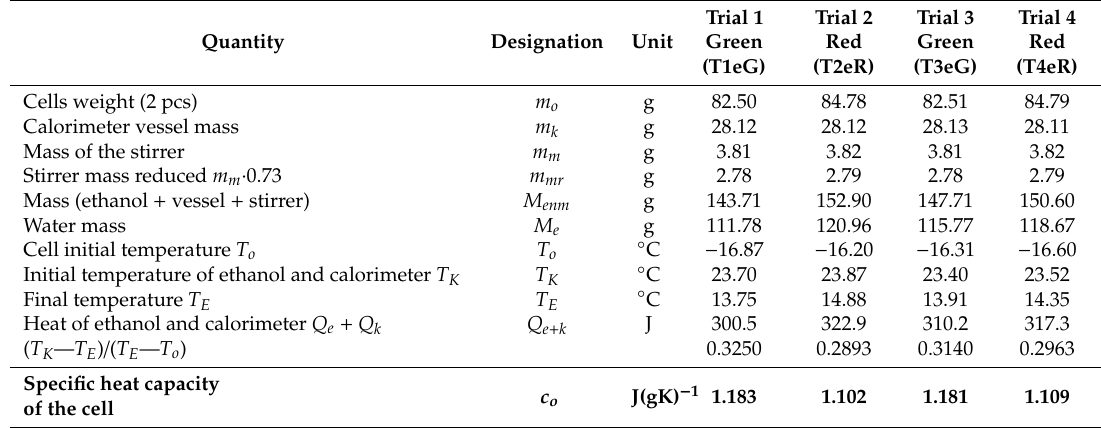
Table 4. Measurement values and the obtained result of specific heat for two types of cells. Ethanol was the heating medium.